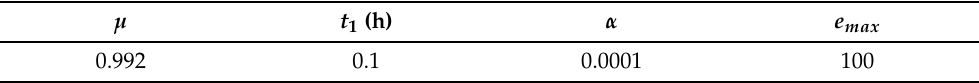
Table 1. CNN Training results, where µ is the learning accuracy, t 1 is the learning time in hours, α is the initial learning rate, and e max is the maximal number of epochs.